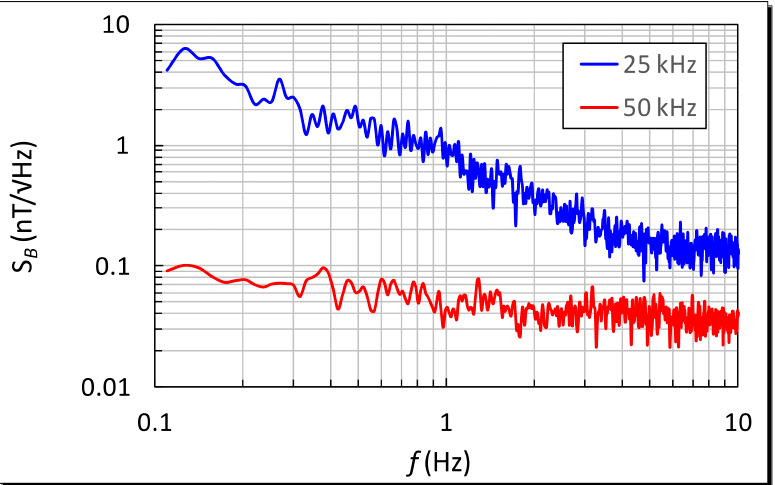
Figure 10. Field noise spectral density of the second harmonics under different excitation